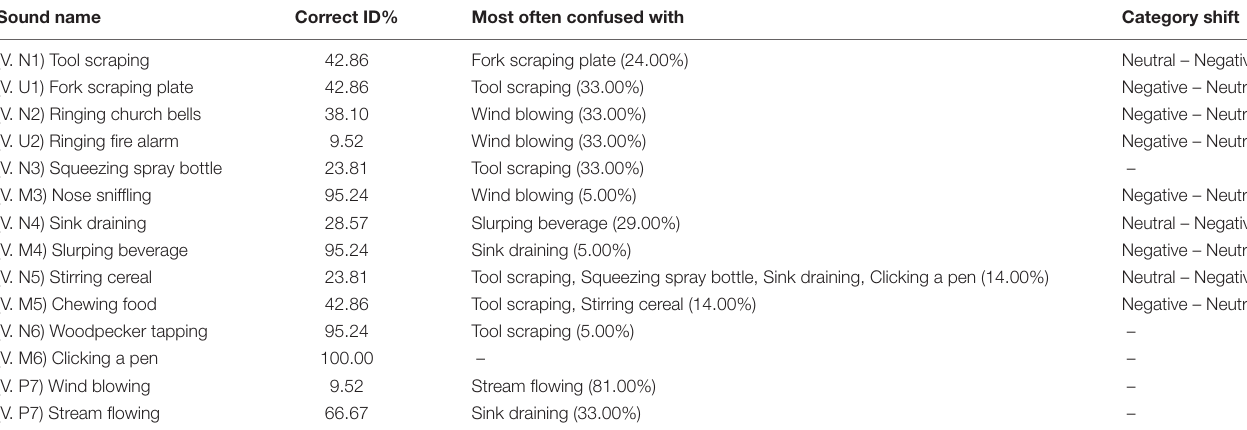
TABLE 6 | Percentage of correct identification for each sound token and the sound it was most confused with across all participants in Experiment